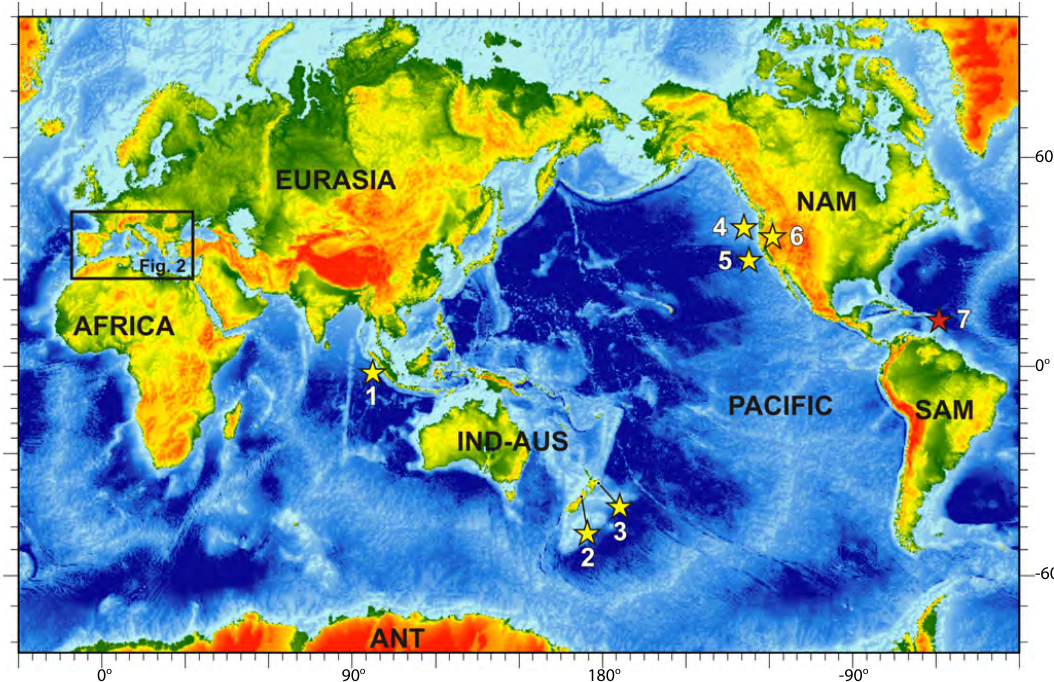
Fig. 1. Topographic and bathymetric world map with the location of all the study areas included in the articles of this Special Issue. Red stars correspond to on-fault paleoseismic studies and yellow stars to off-fault paleoseismic studies. (1) Sumatra subduction zone (Patton et al., 2013); (2) Lake Poerua, South Island, New Zealand (Langridge et al., 2012); (3) Poverty Bay in NE New Zealand (Pouderoux et al., 2012a); (4) Cascadia (Goldfinger et al., 2013b; Morey et al., 2013; Nelson et al., 2012; Patton et al., 2013); (5) northern California Margin (Nelson et al., 2012); (6) Cascade and Klamath mountains, West USA (Morey et al., 2013); (7) Lesser Antilles Arc (Beck et al., 2012). Black rectangle depicts location of Fig. 2. Main plates are located: ANT: Antarctic Plate; IND-AUS: Indo-Australian Plate; NAM: North America Plate; SAM: South America